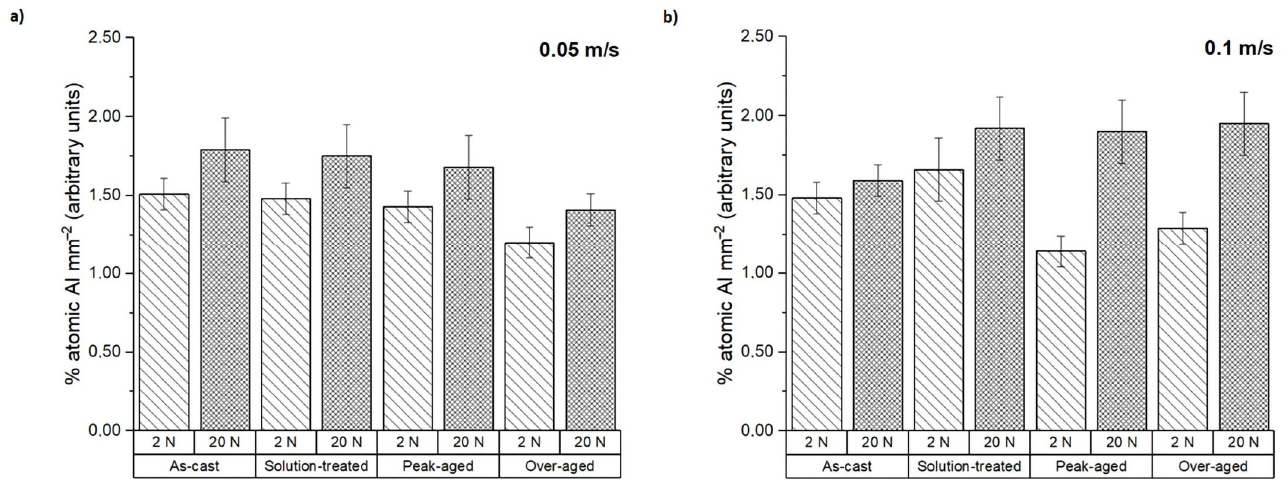
Figure 13. The atomic percentage of oxygen in the debris of the samples tested at ( a ) 0.05 m s − 1 and ( b ) 0.1 m s − 1 .